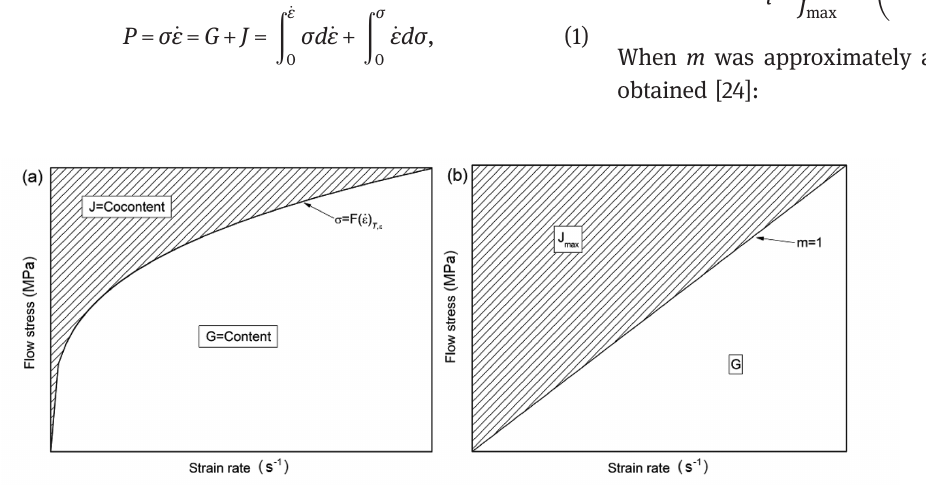
Figure 7: Schematic diagram of energy dissipation based on DMM: (a) nonlinear energy dissipation and (b) linear energy